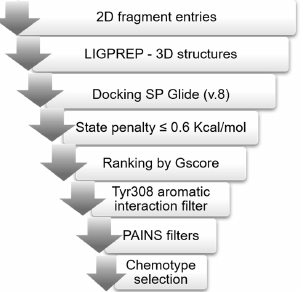
Figure 2. Virtual screening workflow. Ligprep generated 3D structure from 2D fragments; Glide docked the 3D structures into both Rel Seq models (His312 and Hip312). A state penalty filter excluded unfavorable states, and the resulting docking poses were ranked according to Gscore. Only fragments forming an aromatic interaction with Tyr308 were retained, and after removing PAINS, we evaluated the top 1% ranked poses identifying the most representative chemotypes.